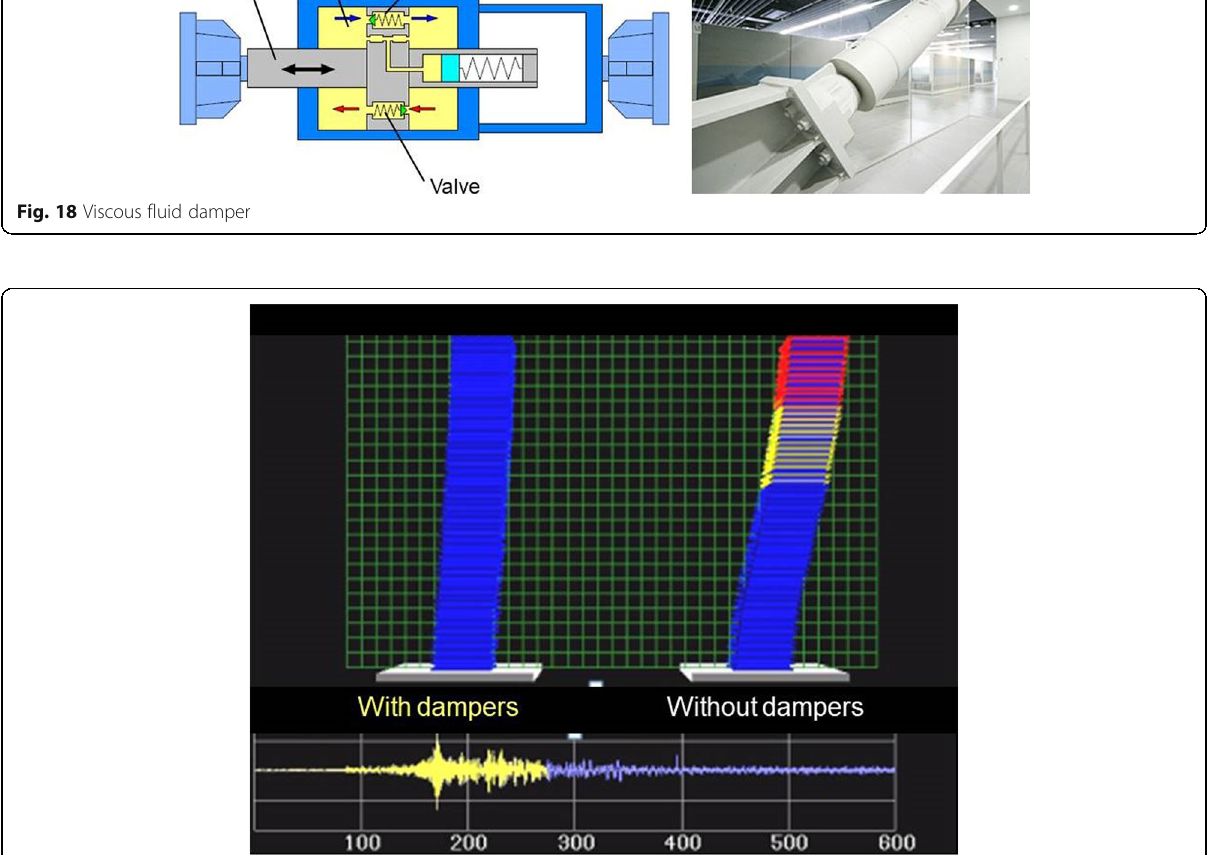
Fig. 19 Earthquake simulation analysis of a 50-story building with and without viscoelastic dampers